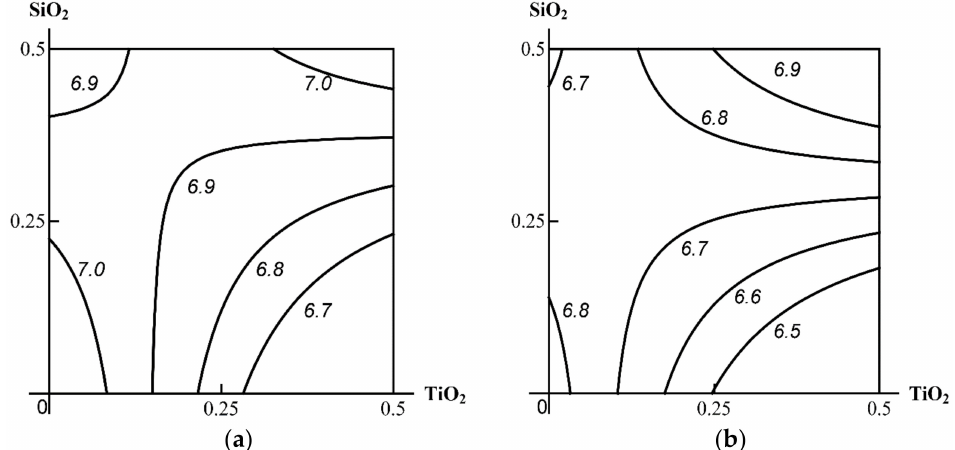
Figure 3. Examples of Class C three-factor toxicity: almost complete coincidence between the isobolograms for the combined effect of SiO 2 + TiO 2 nanoparticles on blood serum glucose ( a ) in the absence of and ( b ) in the presence of Al 2 O 3 NPs. MeO NP doses on the axes are plotted in mg per rat. Numbers on the isoboles show effect values ( µ mol/L).